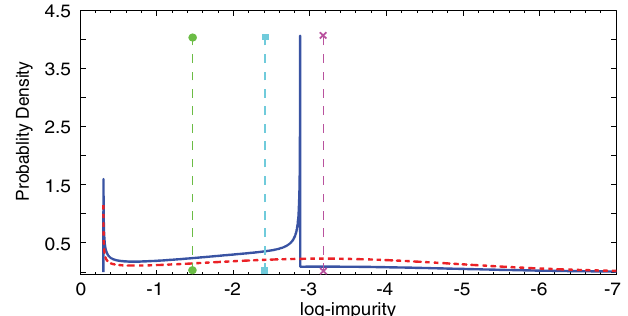
FIG. 21. The distribution of log-impurities at t ¼ 2 (cid:2) (cid:2) 1 . The solid blue curve is the distribution for D ¼ 5 . The dashed red curve is for D ¼ 2 , i.e., Eq. (A21), and is plotted for comparison only. The dashed green line with the circles is log (cid:2) 1 : 46 at t ¼ 2 (cid:2) (cid:2) 1 , according to Eq. (A10). The dashed blue line with the squares is h ‘ i ¼ (cid:2) 2 : 41 at t ¼ 2 (cid:2) (cid:2) 1 . Only a proportion 1 =D of the trajectories has purity lower than (to the right of) the dashed magenta line with the crosses (plotted at ‘ ¼ (cid:2) 3 : 1736 ), as explained in the main text. The two features on the graph at ‘ ¼ (cid:2) 0 : 3010 and ‘ ¼ (cid:2) 2 : 87 correspond to the upper, Eq. (A18), and the pseudolower, Eq. (A19), bounds on the distribution of impurities, as described in the main